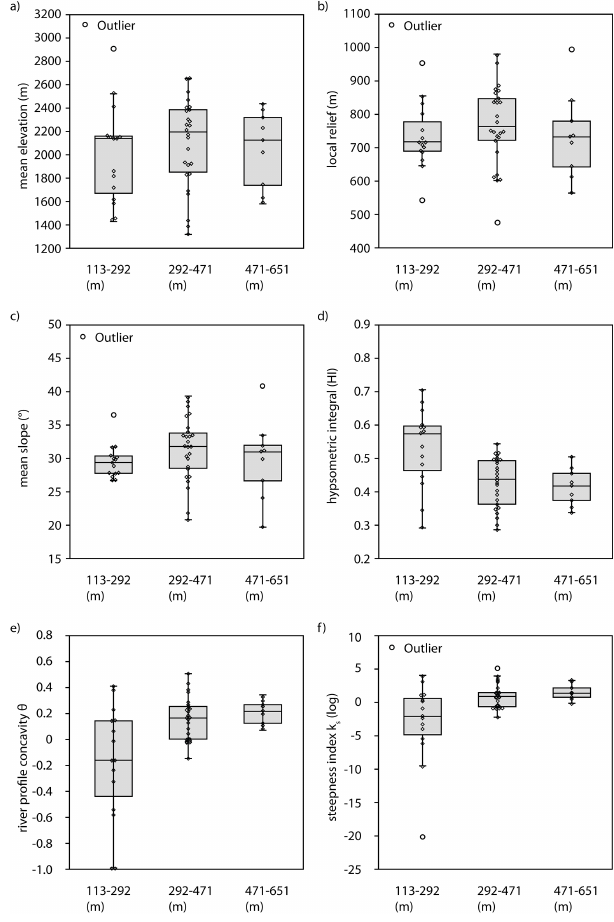
Figure 10. Boxplots of the topographic variables grouped accord- ing to the LGM ice thickness (Bini et al., 2009), which is indicative of glacial